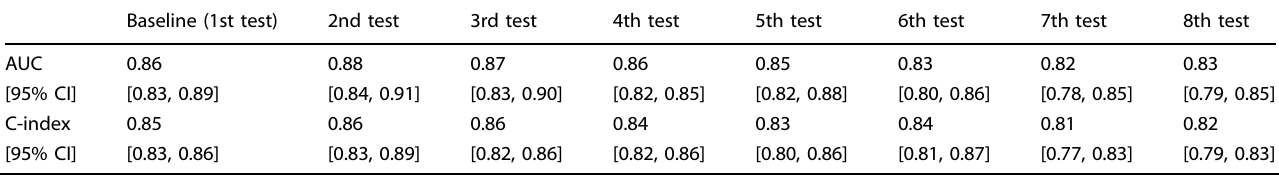
Table 3. Prediction strength of laboratory tests on successive days using baseline cut-off values.